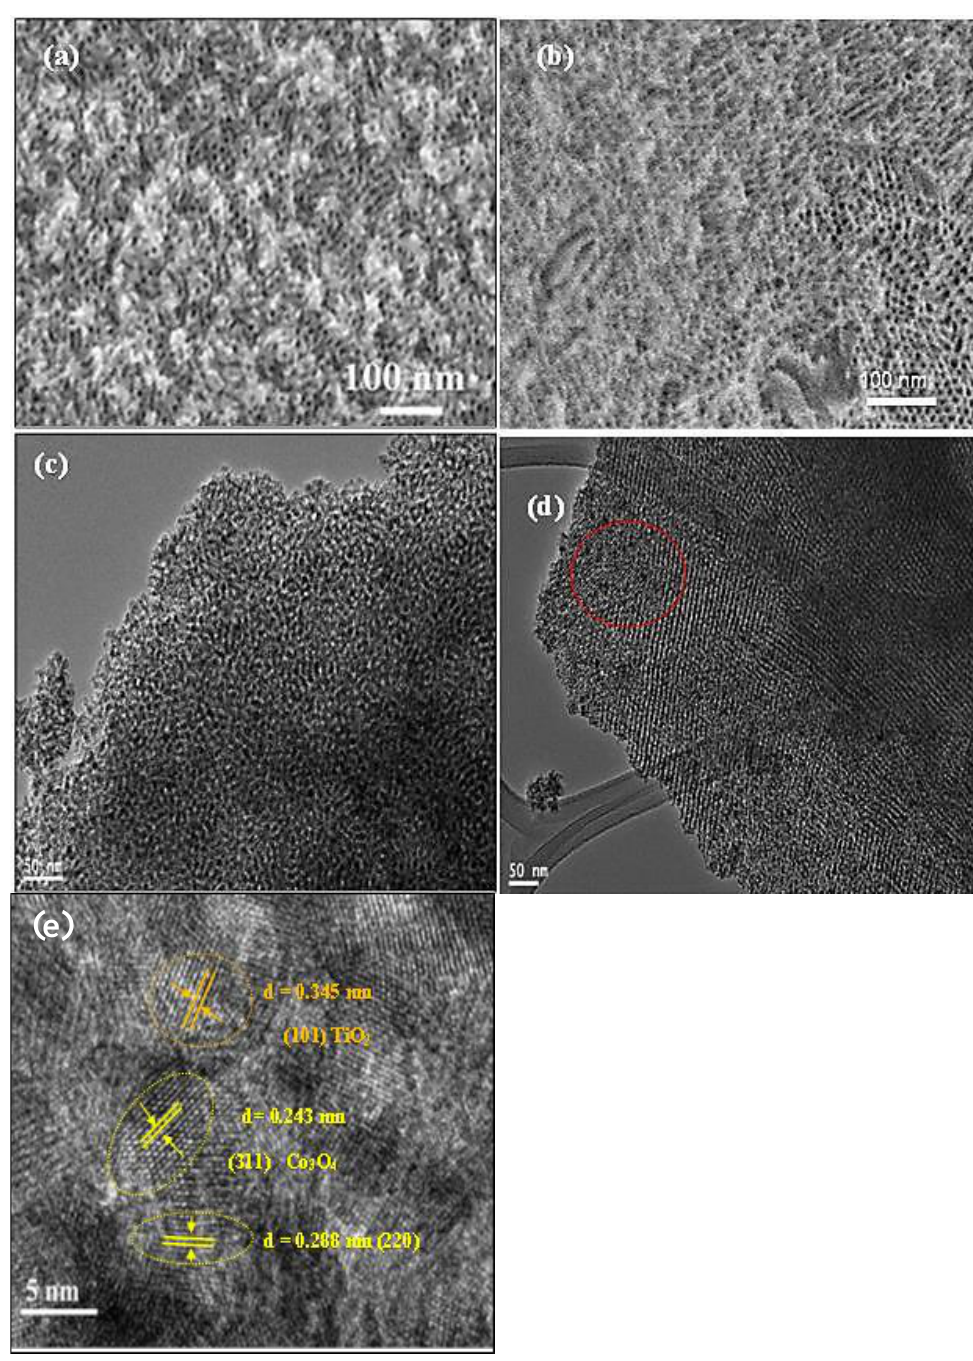
Figure 1. SEM images of ( a ) Co 3 O 4 (3) / lsm -TiO 2 and ( b ) Co 3 O 4 (3) / hm -TiO 2 ; typical TEM images of ( c ) Co 3 O 4 (3) / lsm -TiO 2 , ( d ) Co 3 O 4 (3) / hm -TiO 2 , and ( e ) high resolution TEM of Co 3 O 4 (3) / hm -TiO 2